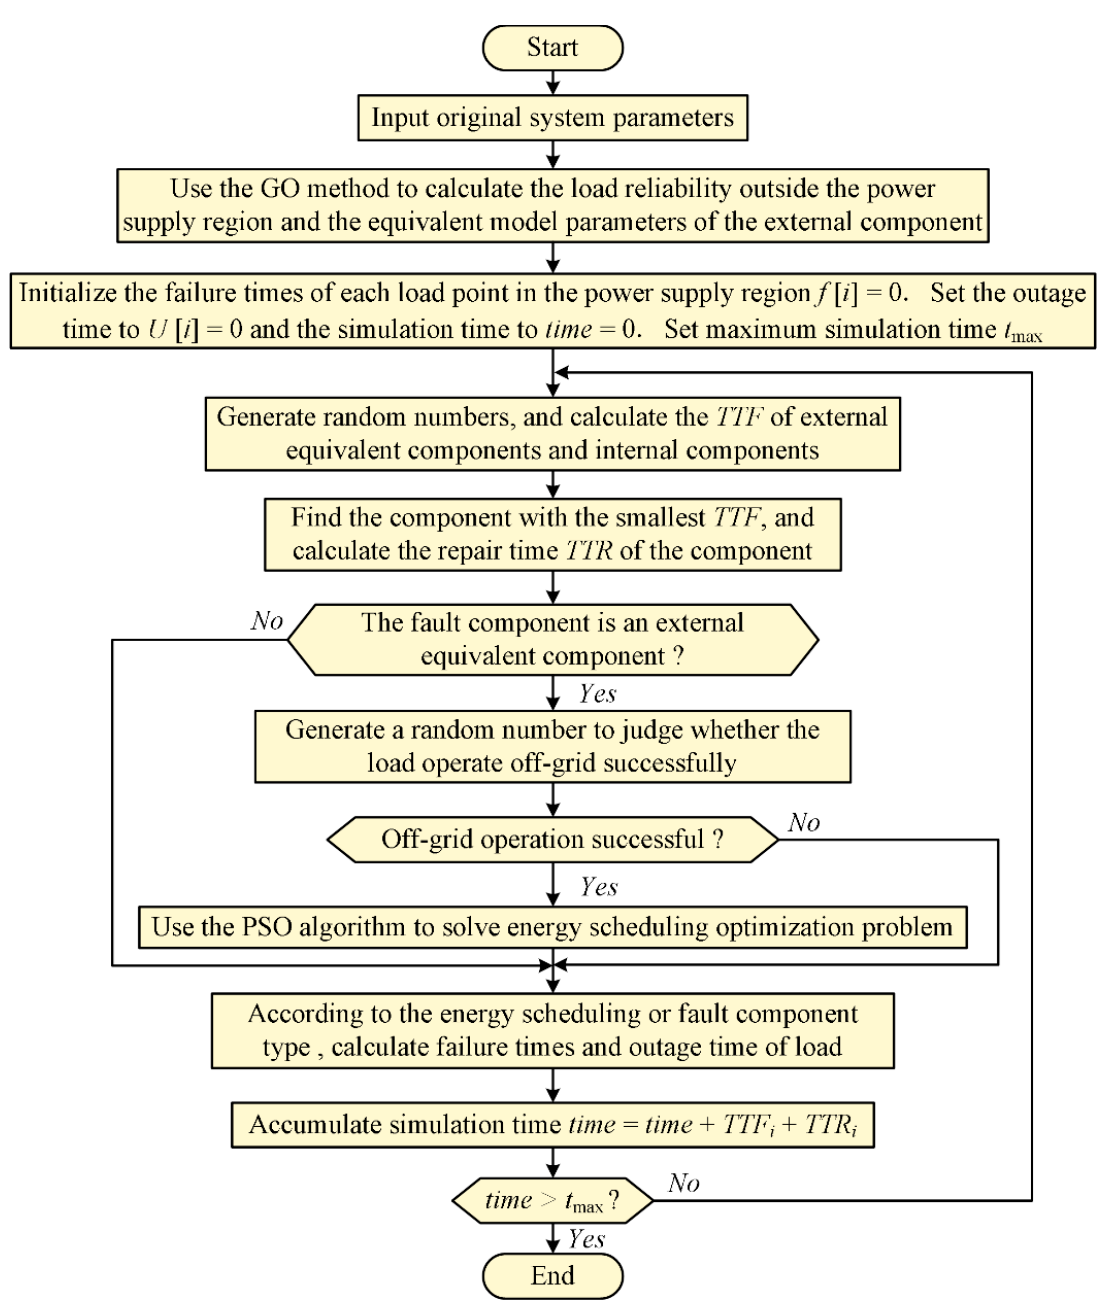
Figure 5. Hybrid method flow chart.